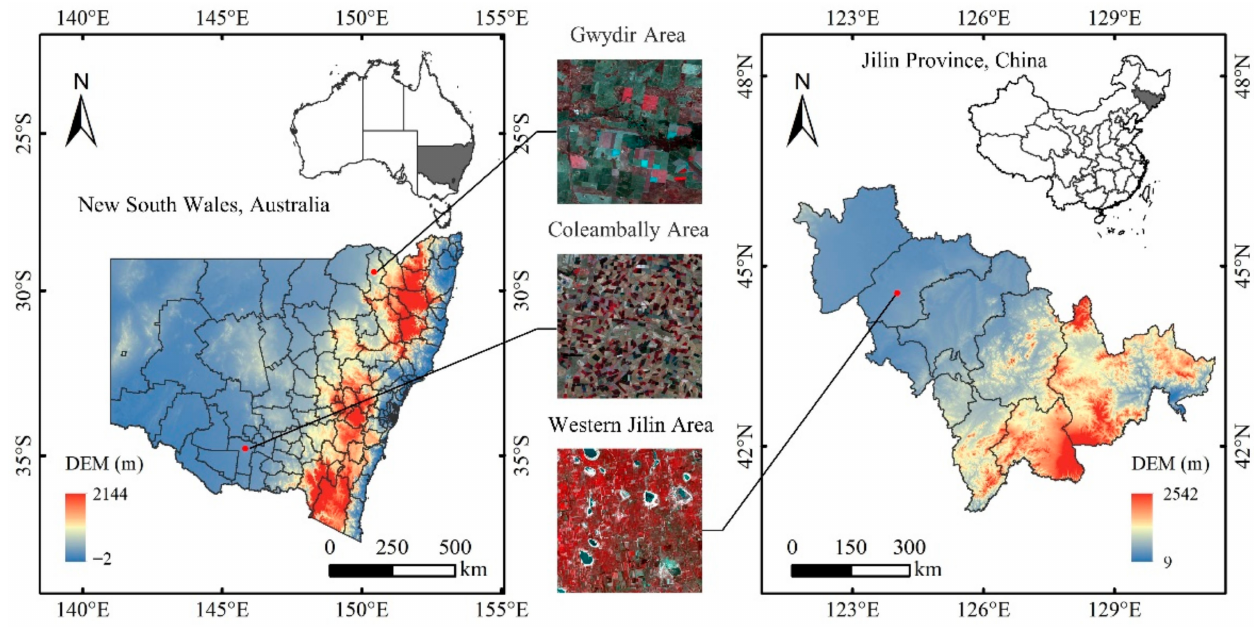
Figure 3. The location of the test